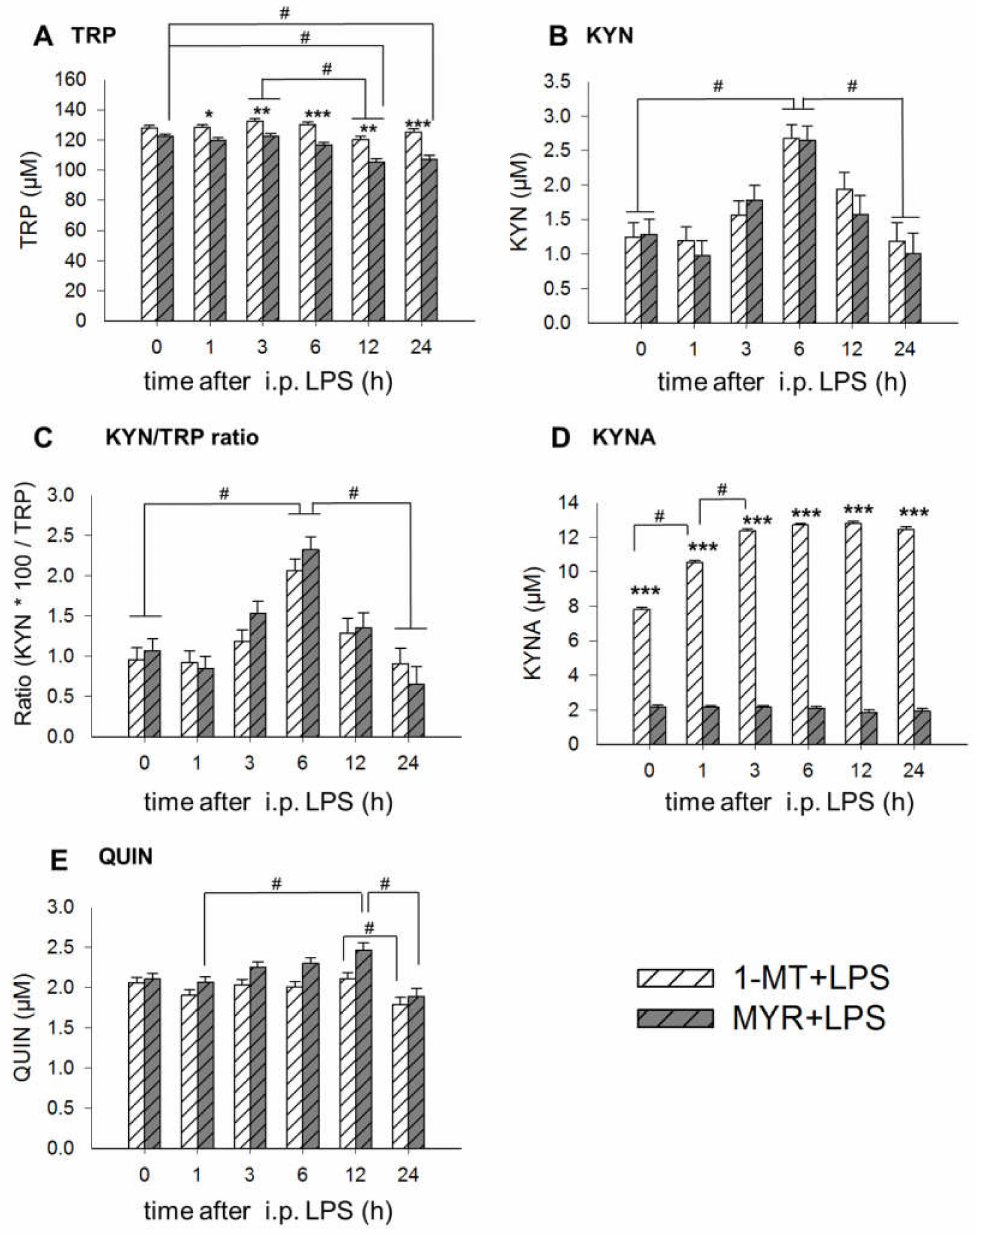
Figure 2. Effects of 1-MT on LPS-induced changes of TRP ( A ), KYN ( B ), KYN/TRP ratio ( C ), KYNA ( D ) and QUIN ( E ) in plasma. As a control for 1-MT-induced effects the excipient MYR was used. TRP and its metabolites were measured using MS/MS and the KYN/TRP ratio was used as a marker for IDO1 activity. LPS was injected i.p. directly after blood sampling at 0 h. The animals received the fifth s.c. 1-MT or MYR injection at 12 h after LPS. The results are presented as LS-means ± SE. Tukey–Kramer procedure was used for all pairwise comparisons. Significant differences are indicated between 1-MT and MYR groups for each time point by asterisks, and between the sampling times by hashes. For the sampling times 0, 1, 3, 6 h: n = 11-12/group (total n = 47); for time point 24 h: n = 5-6/group (total n = 23); *** p < 0.001, ** p < 0.01, * p < 0.05, # p <